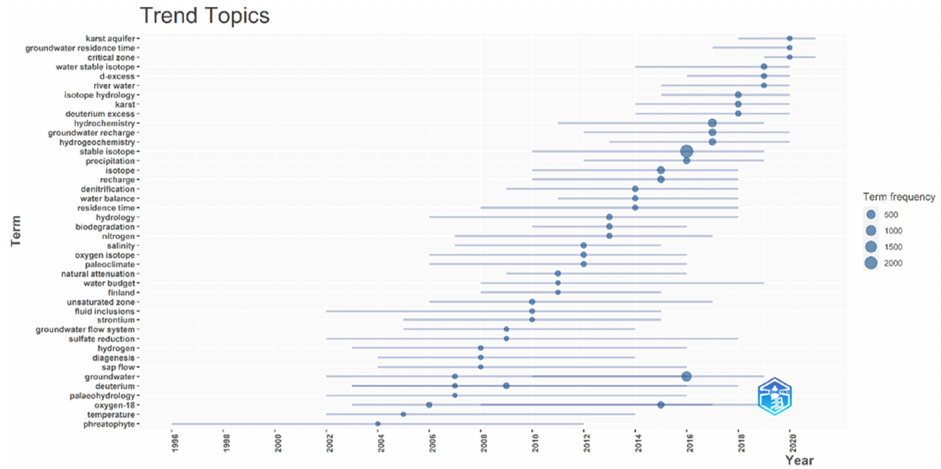
Figure 7. The trend of keywords by year of the GSI.